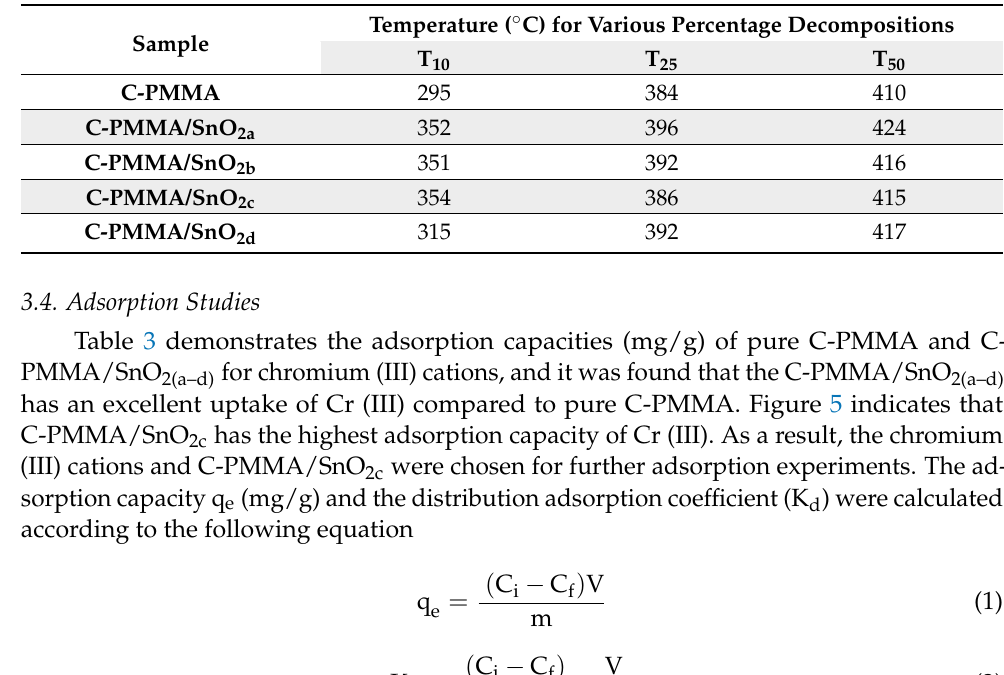
Table 2. Thermal behavior of C-PMMA and C-PMMA/SnO 2(a–d) nanocomposites.